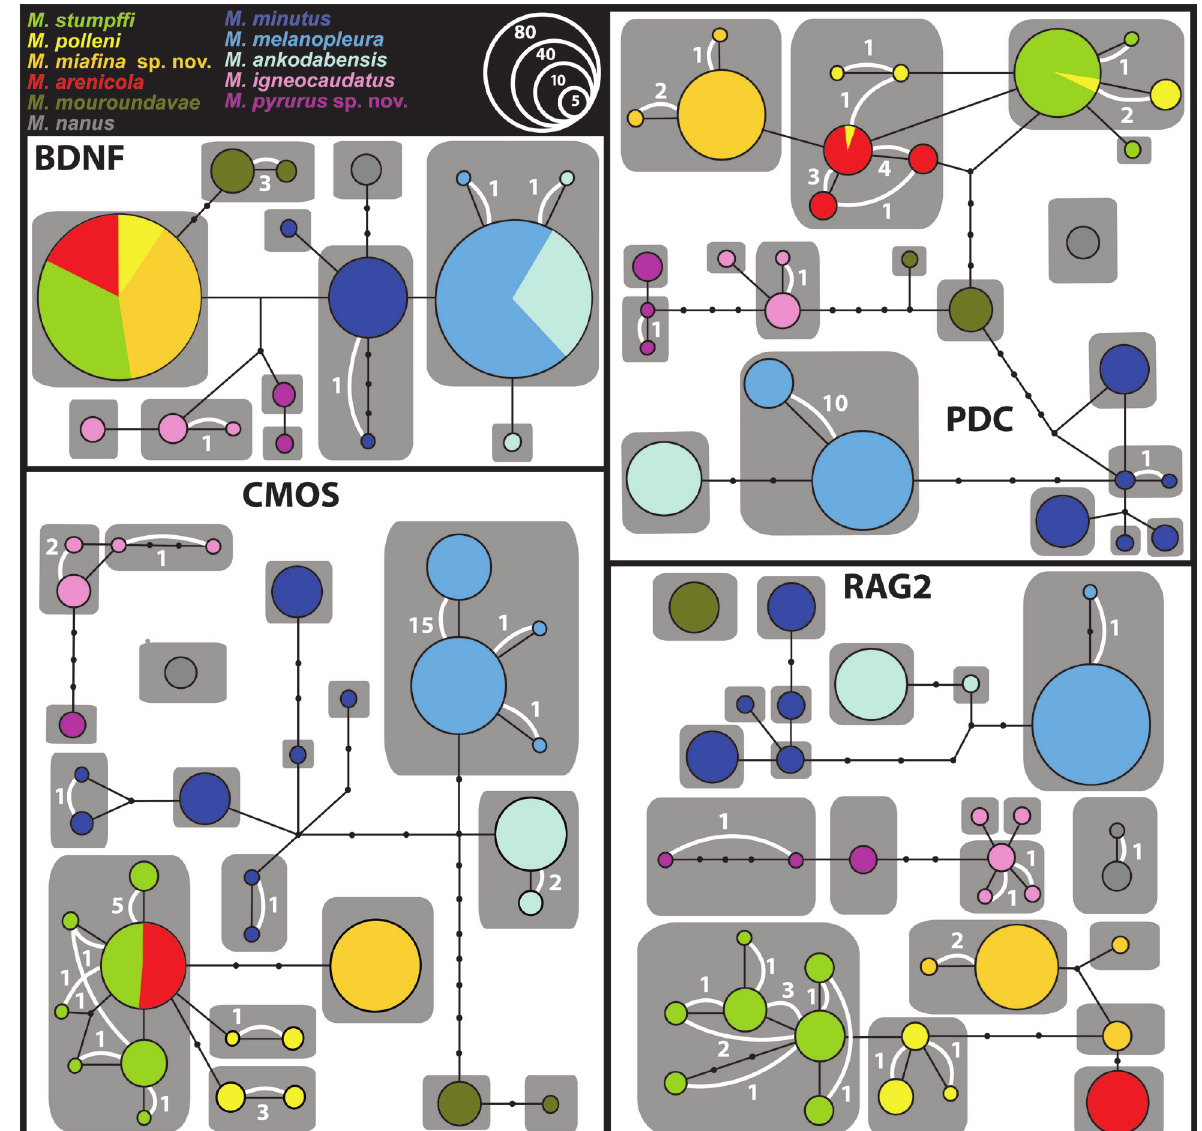
Figure 2. Haplotype network reconstructions for the four nuclear genes (BDNF, PDC, CMOS and RAG2). For each marker, circles represent haplotypes (size proportional to the number of individuals), black lines represent mutational steps and black dots missing haplotypes, white curves represent connections between haplotypes found co-occurring in heterozygous individuals, and white numbers represent the number of individuals in which the respective haplotypes were found co-occurring. Single locus fields of recombination (pools of co-occurring haplotypes) are represented by grey rectangles (redrawn from Miralles and Vences